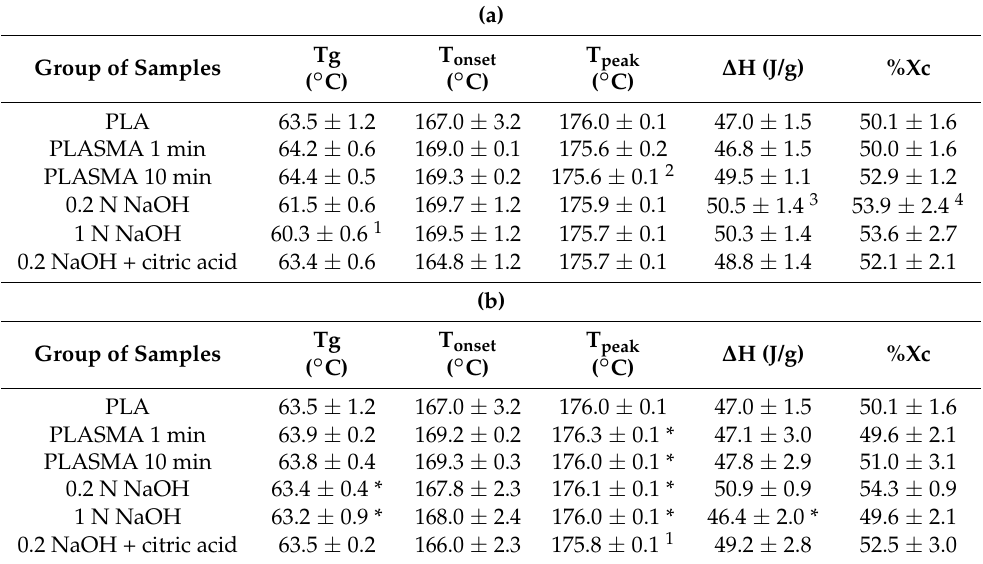
Table 2. DSC results of all groups of samples on day of treatment (a) and two weeks later (b).